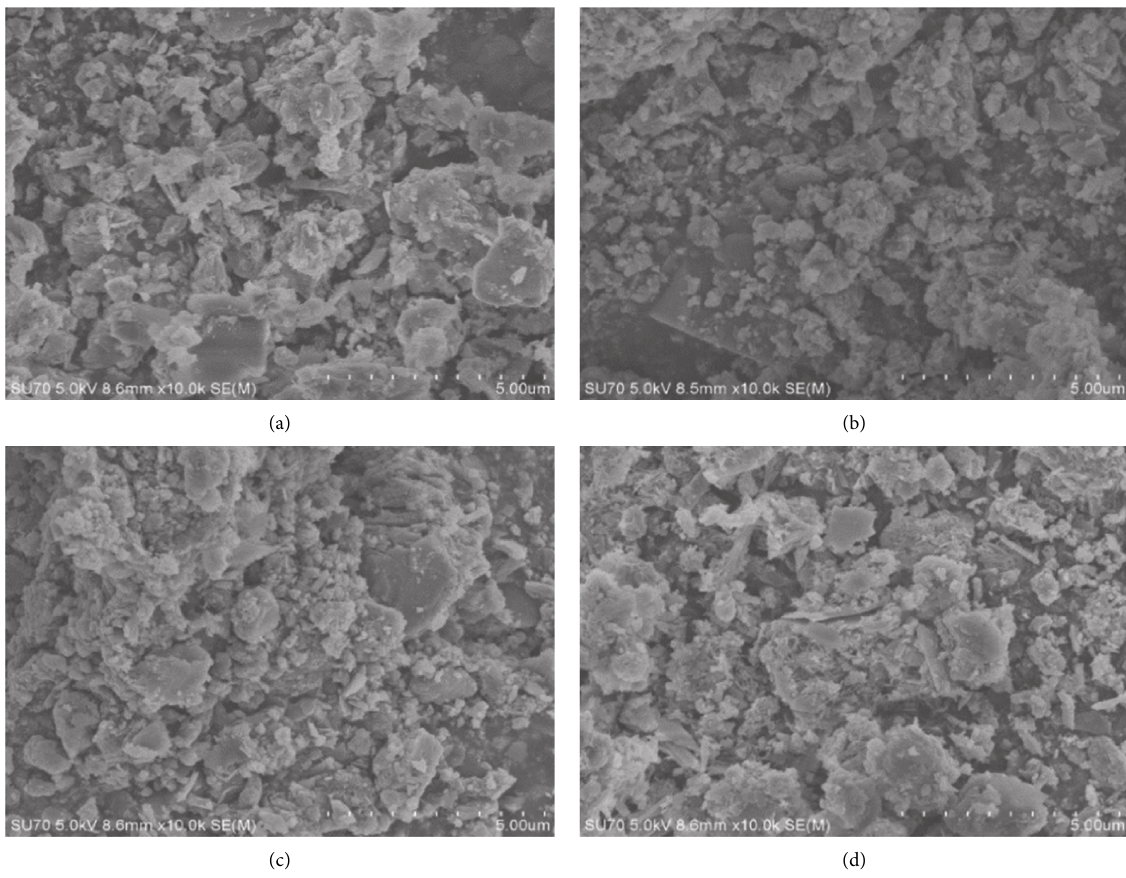
Figure 7: SEM of cement paste with different corrosion inhibitors.